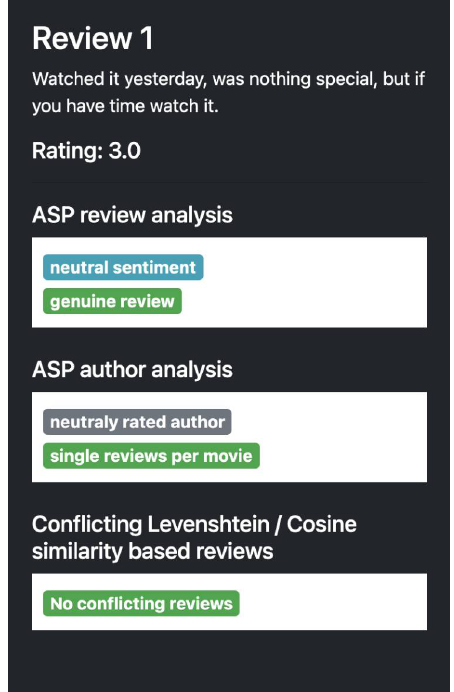
Figure 3. Neutral review